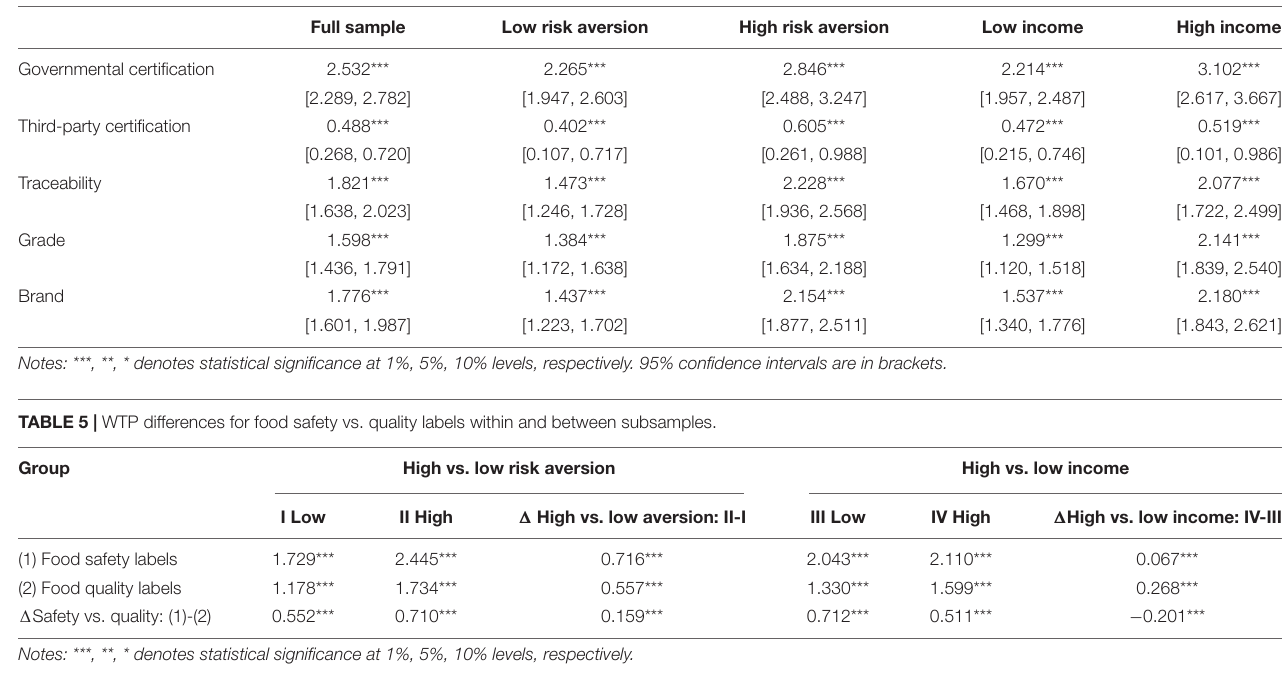
TABLE 4 | Estimated WTP (CNY/500g) of full sample and subsamples.